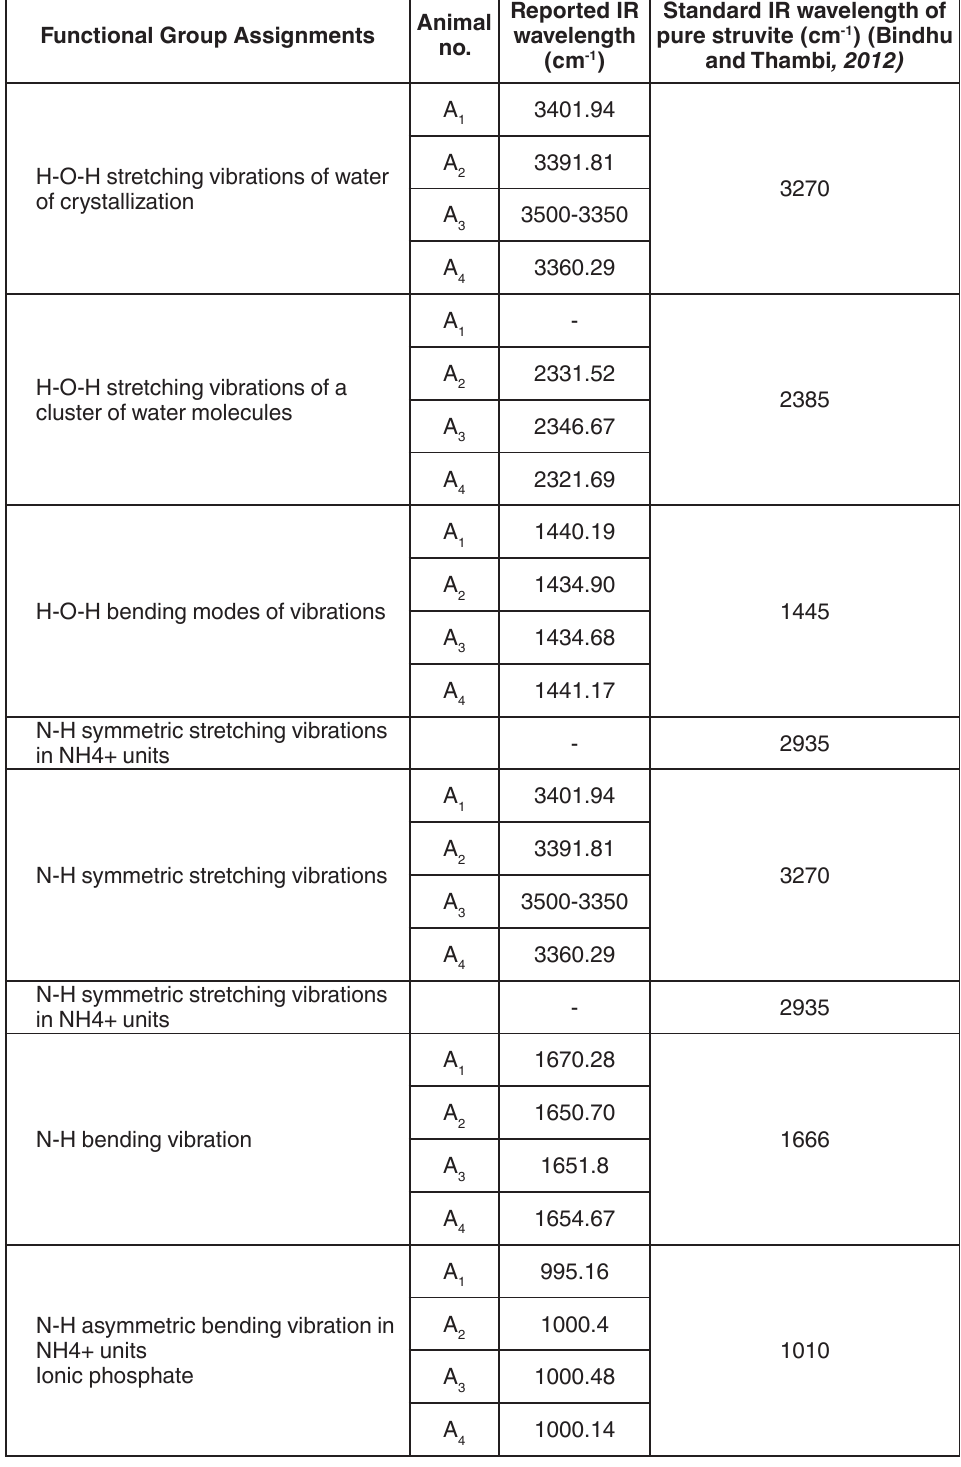
Table 1. Results of analysis of calculi in Fourier Transform Infrared Spectrometry with Attenuated Total Reflectance